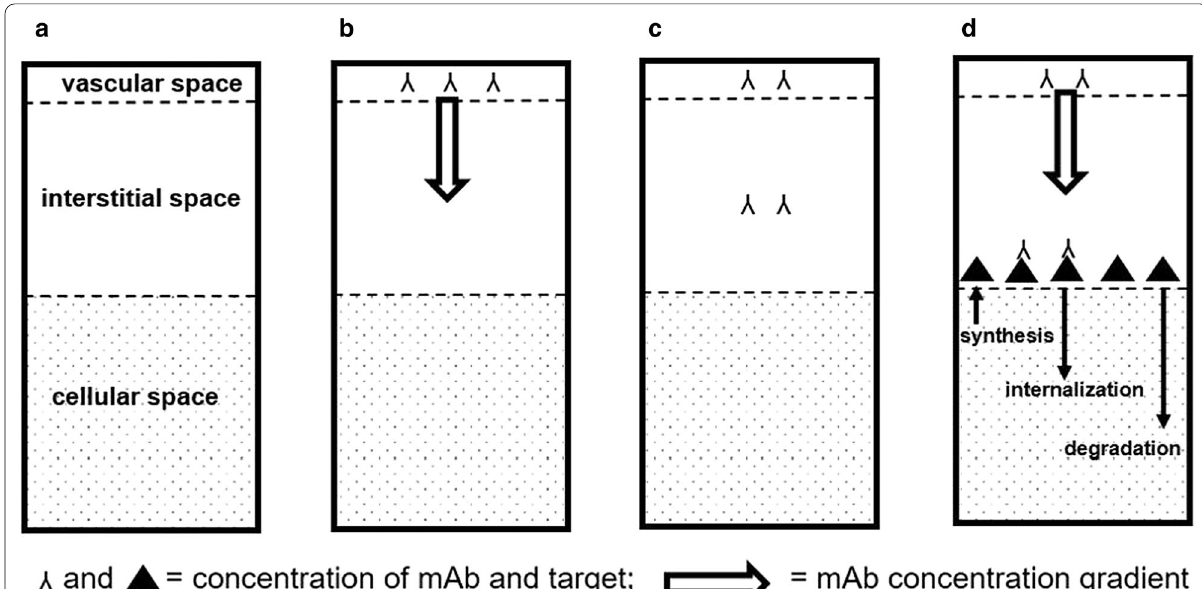
Fig. 1 Tumor uptake of mAbs. Tumor volume fractions ( a ). Distribution of mAb after administration ( b ). Equilibrium distribution of mAb in a tumor without target expression ( c ). Distribution of mAb in a HER2‑positive tumor ( d ). Target can be synthesized and degraded, mAb‑target complexes can be